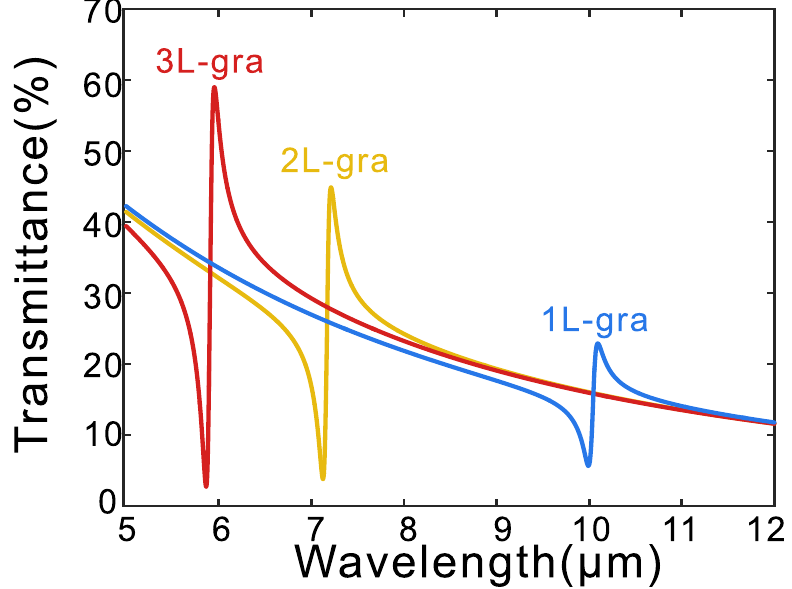
Figure 2. Simulated spectra of transmission for ( a ) Graphene nanodisks and ( b ) The hybrid metal-graphene metamaterial with different layers of